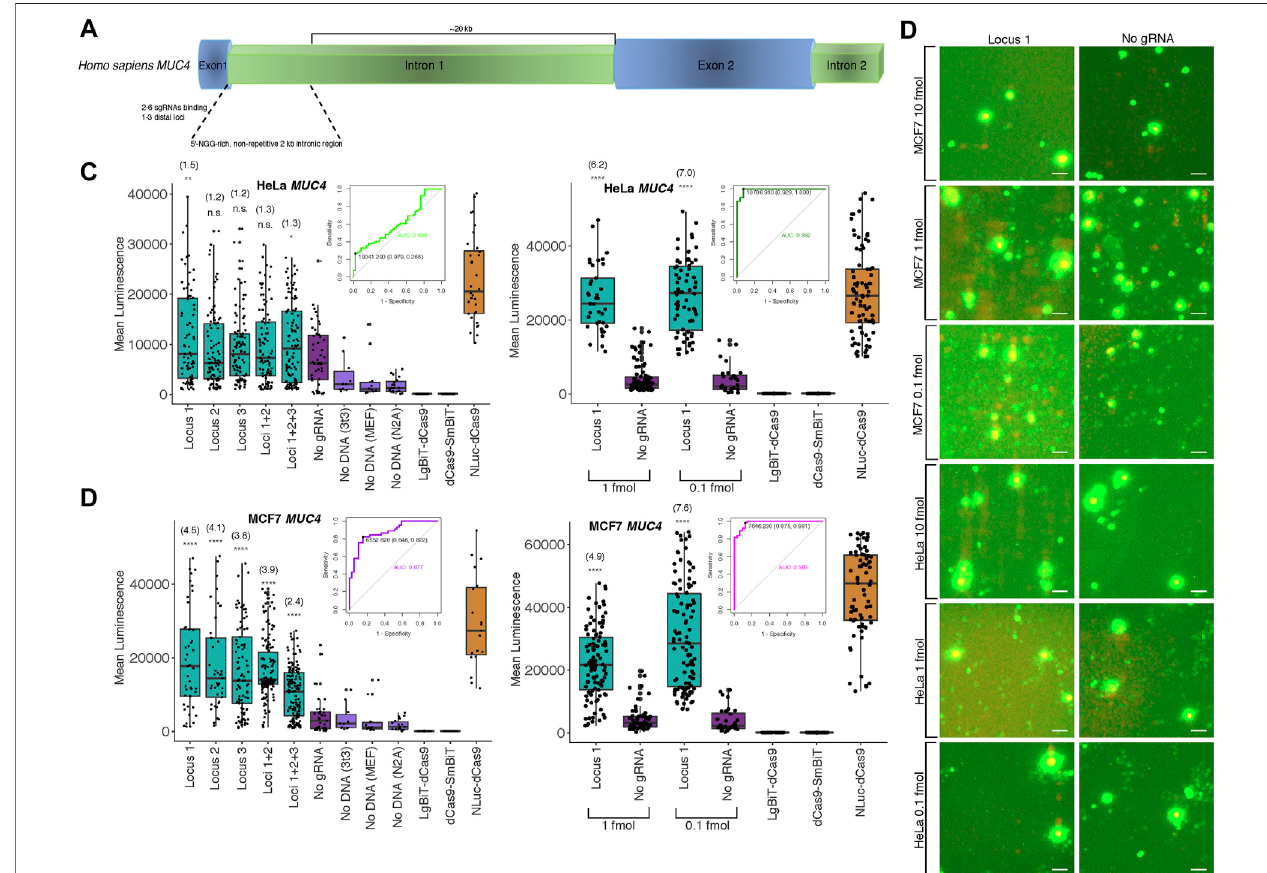
FIGURE3| Biosensingnon-repetitivegenomicsequencesatthehuman MUC4 locus (A) Cartoonvisualizationofthenon-repetitiveregionwithinintron1ofhuman MUC4 showing sgRNA design strategy. (B) Merged fl uorescence (green) and luminescence (red) images taken on the Leica DM6000B upright microscope at 10 × magni fi cation depicting dCas9-NanoBiT biosensing of a single locus within non-repetitive MUC4 intron 1 in live MCF7 and HeLa cells. Scale bars = 50 μ M. (C) Signal quanti fi cation for images taken of the dCas9-NanoBiT probe binding to several combinations of loci in the non-repetitive region of MUC4 intron 1 in HeLa cells at 10 fmol probe transfected (left) and for images taken of the probe binding to a single non-repetitive locus within MUC4 intron 1 at 1 and 0.1 fmol probe transfected in HeLacells(right).Apparentsignal-to-backgroundratios(nosgRNA=backgroundcondition)arelistedinparentheses.32 < n < 150forHeLacellsat10 fmoland28 < n < 100 forHeLacells atthe twolowerconcentrations, where n representsthenumber ofuniquecellsquanti fi ed; unpairedtwo-sidedStudent ′ s t -test, * p < 0.05; ** p < 0.01; *** p < 0.001; **** p < 0.0001. Receiver Operating Characteristic (ROC) curves representing biosensing results at MUC4 locus 1 at 10 fmol (left) and 1 fmol (right) probe transfected in HeLa cells are shown. (D) Signal quanti fi cation for images taken of the dCas9-NanoBiT probe binding to several combinations of loci in the non-repetitive regionof MUC4 intron1inMCF7cells(left)andforimagestakenoftheprobebindingtoasinglenon-repetitivelocuswithin MUC4 intron1 attwolowerconcentrationsin MCF7 cells (right). Apparent signal-to-background ratios are listed in parentheses. 19 < n < 159 for MCF7 cells at 10 fmol and 32 < n < 106 for MCF7 cells at the two lower concentrations, where n representsthe number ofunique cells quanti fi ed; unpaired two-sided Student ′ s t -test, * p < 0.05; ** p < 0.01; *** p < 0.001;**** p < 0.0001. Receiver Operating Characteristic (ROC) curves representing biosensing results at MUC4 locus 1 at 10 fmol (left) and 1 fmol (right) probe transfected in MCF7 cells are shown. Boxes show median and IQR and whiskers show dispersion from IQR.